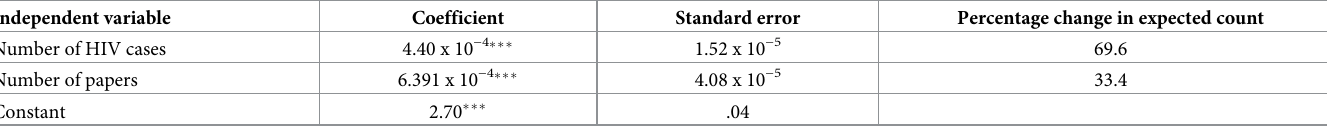
Table 4. Coefficients of Poisson regression model with number of tweets as dependent variable (n = 44 US states). Independent